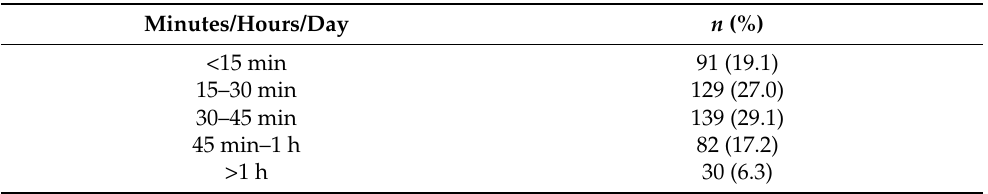
Table 3. Physical activity averages with moderate-intensity activities among RDNs during the COVID-19 pandemic. n (%).